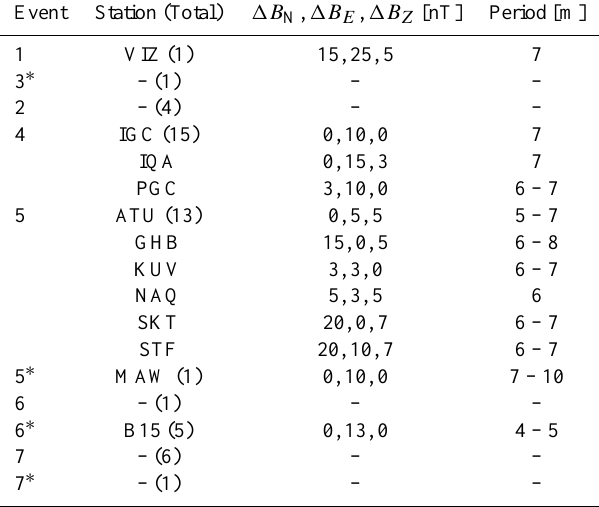
Table 10. Summary of SuperMAG clear quasi-periodic oscilla- tions in the Northern and Southern Hemisphere to include station acronym, change in magnetic field, and period. The asterisk refers to stations in the Southern Hemisphere. Station (Total) refers to the station name which displayed results and the total number of Super- MAG stations that were within the geographic range of our event. Only those stations which provided clear quasi-periodic oscillations are documented.